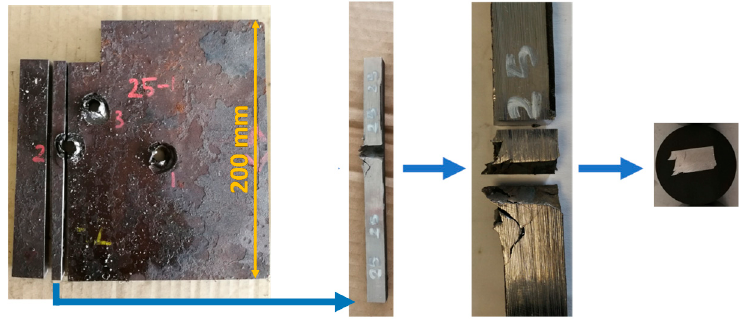
Figure 5. Preparation of the cross-sectional examination samples.